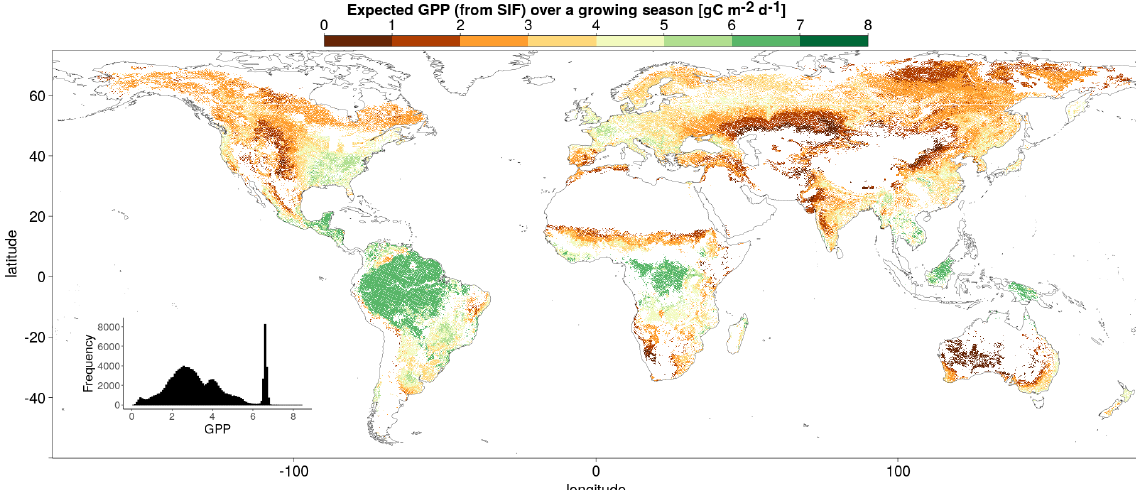
Figure 8. The global GPP estimated from the downscaled SIF and the SIF DS –GPP FX spatial linear relationships between vegetation group- ings suggested from the results of the analysis of